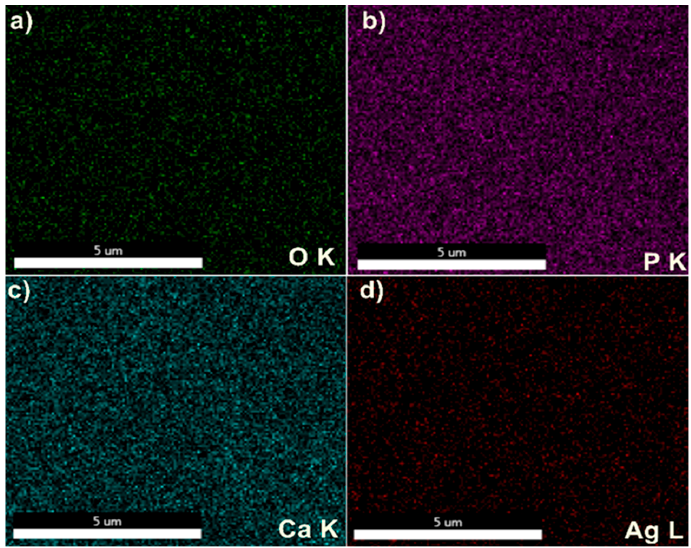
Figure 8. Elemental mapping of the Ag:HAp-S1 composite layers.